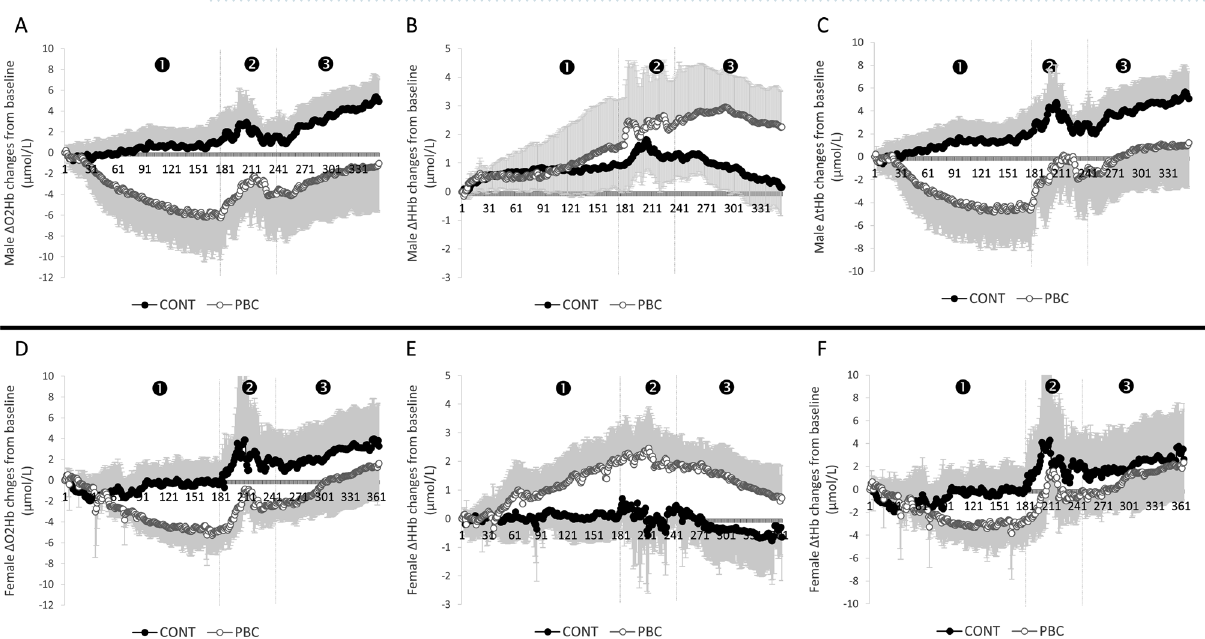
Figure 5. Changes in cerebral oxygenation during and after the 3-min cryostimulation and control (CONT) conditions. 1—PBC/ 2—exit of PBC (1 min)/ 3—sitting time (2 min). ( A – C ) Shows the kinetics of ΔO 2 Hb, ΔHHb and ΔtHb, respectively, in males. ( D – F ) Show ΔO 2 Hb, ΔHHb, and ΔtHb in females. PBC partial body cryotherapy,